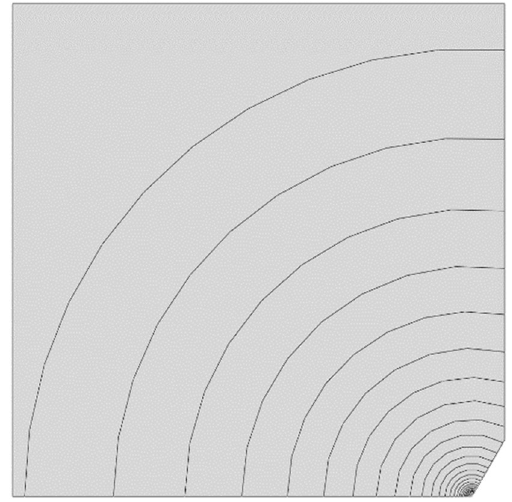
Fig. 12 Radial layers emanating from crack tip for plate with 120-degree v-notch